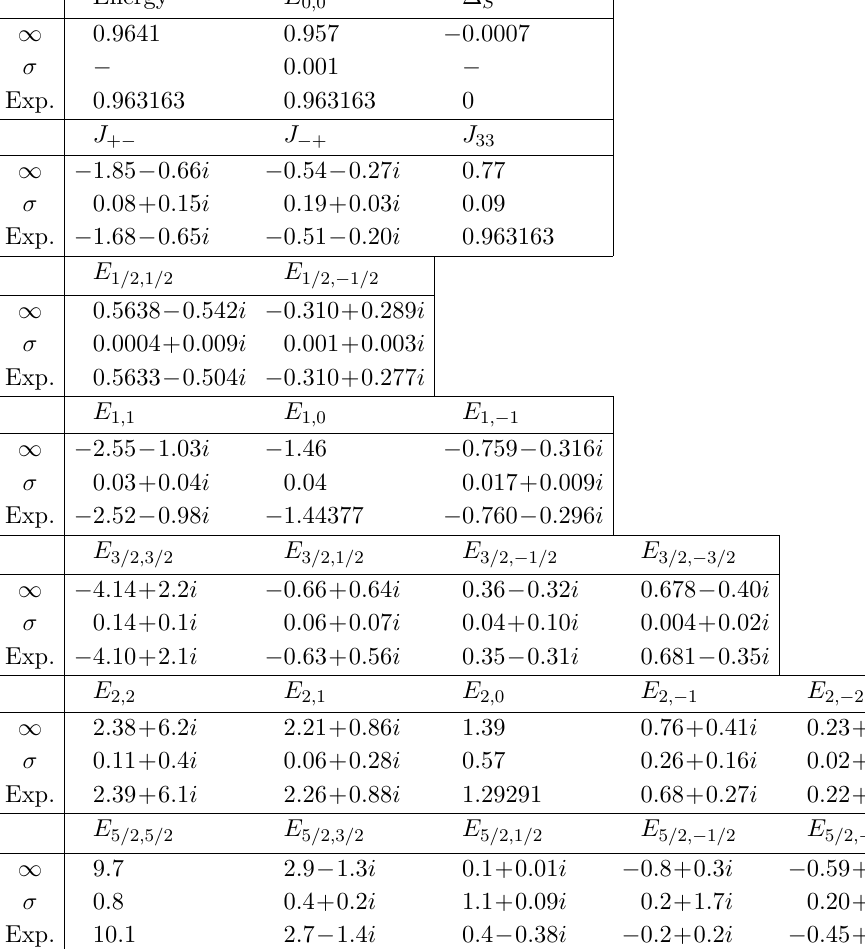
= − 2 π and ρ 1 . 82 in the k = 5 model with J = 1 2 2 ≈ k